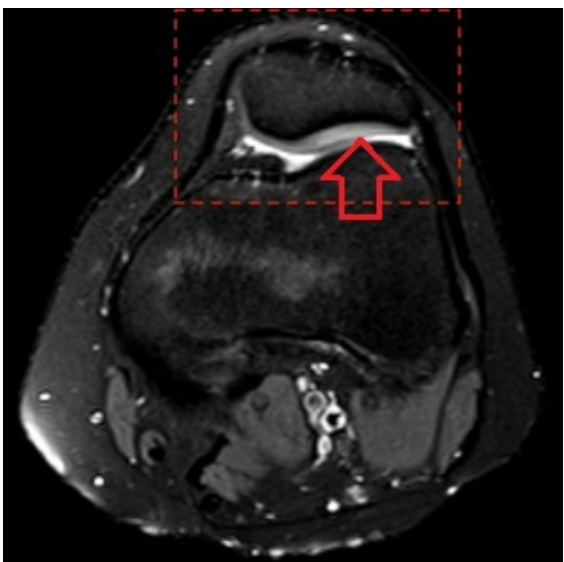
Figure 2. Patellar cartilage edema and retropatellar effusion. Table 3. Age-related differences in prevalence of specific morphological substrates in pediatric patients with knee overuse